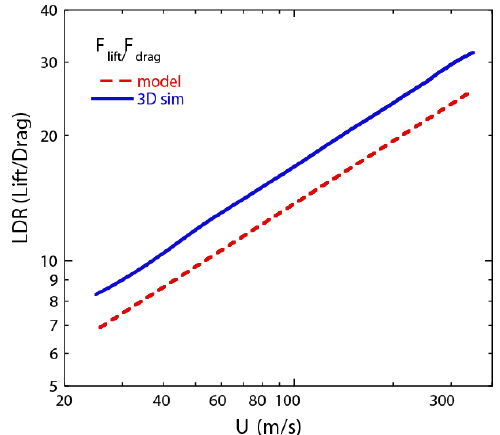
Figure 12. Comparison of Lift/Drag ratio between the present model and the 3D FEM in Reference Figure 12. Comparison of Lift / Drag ratio between the present model and the 3D FEM in Reference [18]. [18]. Both curves show power-law behavior ( ). Specific parameters used for the comparison: Both curves show power-law behavior ( ∼ U 1/2 ). Specific parameters used for the comparison: (cid:13)/(cid:14) ~(cid:1) permeability µ 0 = 1.257 × 10 − 6 N/A 2 , pole pitch λ = 0.5 m, wavenumber k = 12.56 / m, track electrical resistivity ρ = 2.65 × 10 − 8 Ω